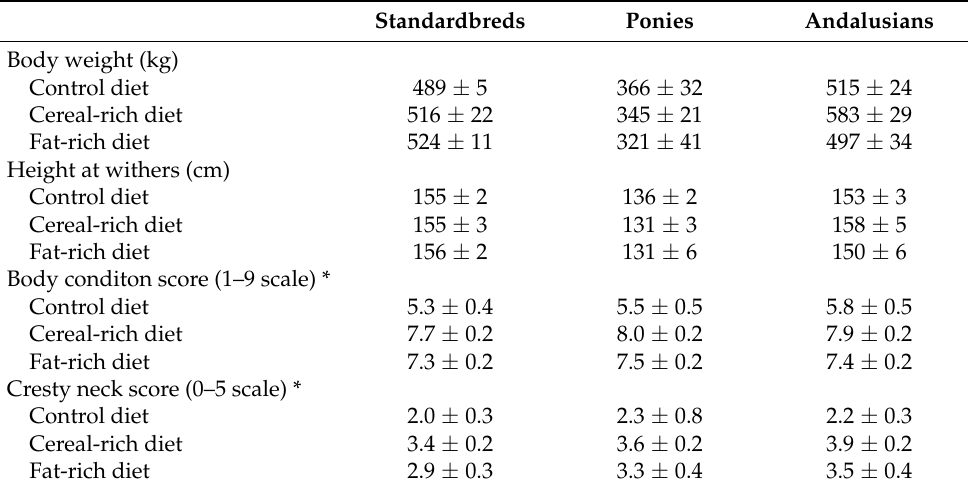
Table 2. Morphometric characteristics of Standardbred horses, ponies and Andalusian horses adapted to consuming a control diet ( n = 3 of each breed), cereal-rich diet ( n = 4 of each breed) or fat-rich diet ( n = 4 of each breed) at the time of digestibility collections (mean ± standard error). Standardbreds Ponies Andalusians 489 ±